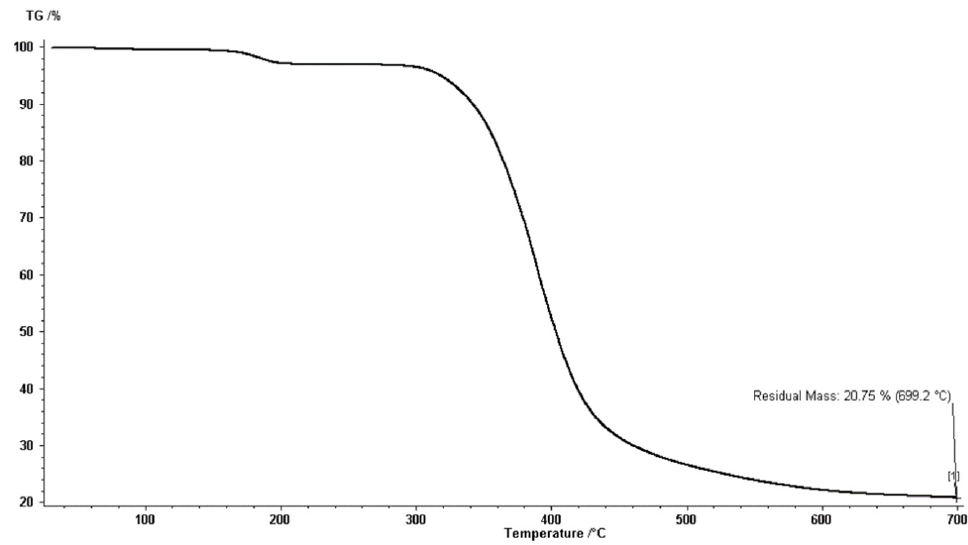
Figure 4. TGA thermogram of the hyperbranched polyester.